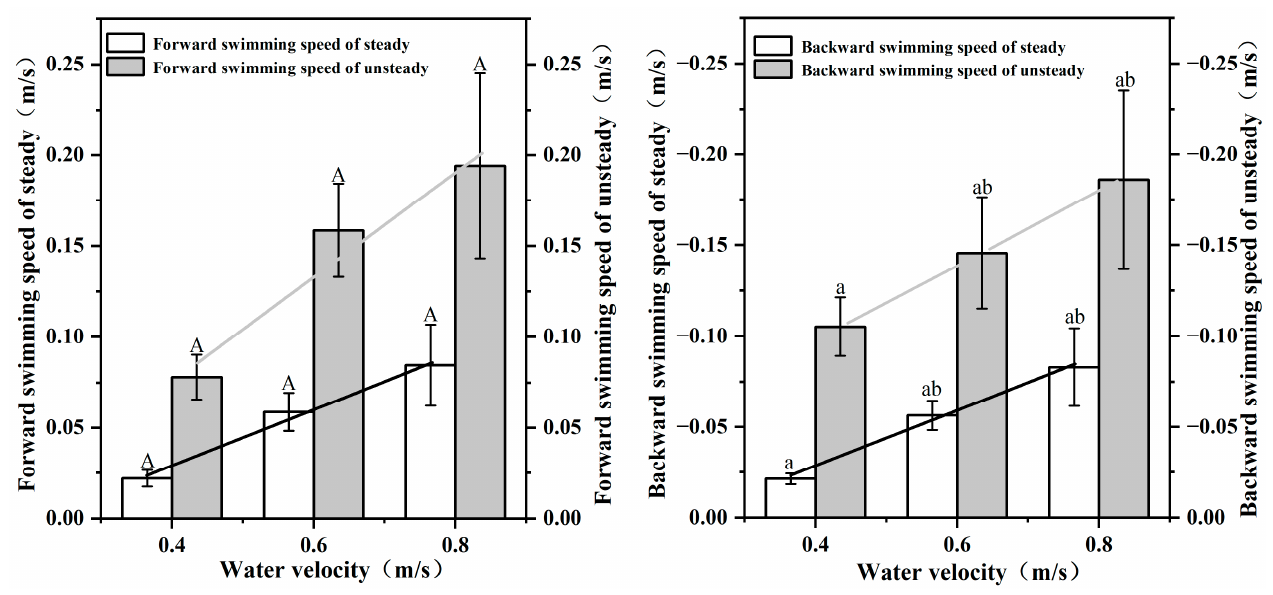
Figure 4. Relationship between forward/backward velocity and water flow velocity in steady/unsteady mode of S. malacanthus swimming. Different upper cases indicate the significant the difference of water velocity in forward swimming speed of steady/unsteady treatments; Different lower cases indicate the significant the difference of water velocity in backward swimming speed of steady/unsteady treatments.